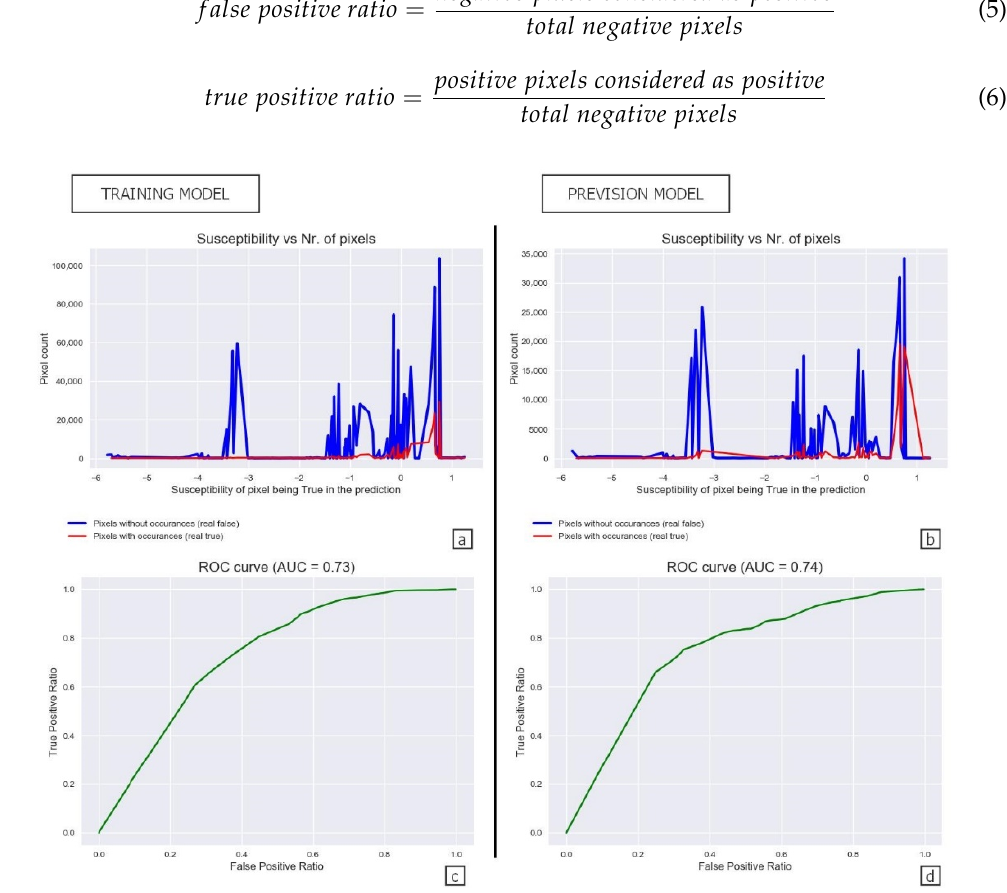
Figure 5. Graphics generated by the developed script in the wildfire susceptibility modeling with the land use and slope variables: frequency of pixel susceptibility classification ( a , b ) and ROC curve for the classifier ( c , d ).